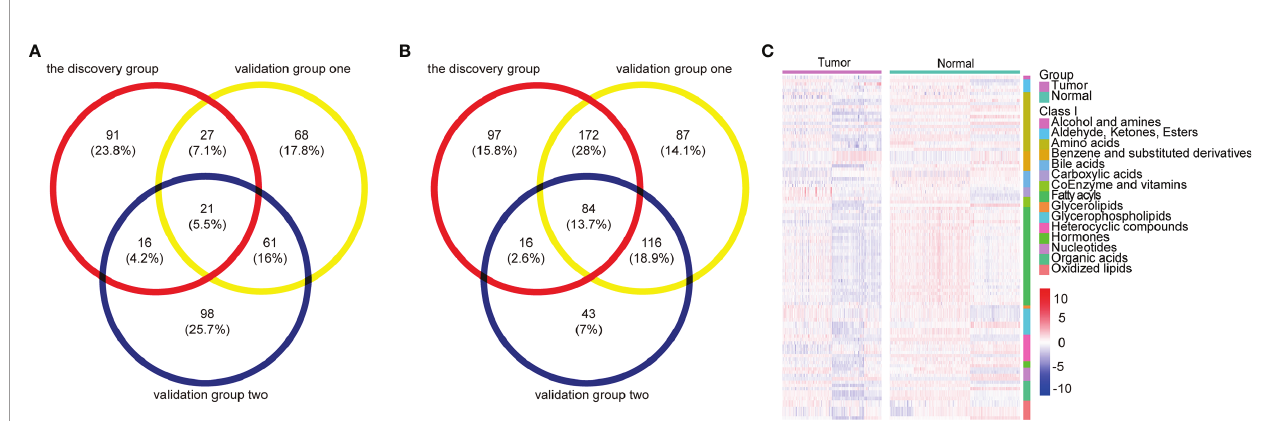
FIGURE 2 | Metabolomic pro fi les of patients with ESCC compared with controls. (A, B) Venn diagram of differential metabolites overlaps from the discovery and validation groups: 21 upregulated (A) and 84 downregulated (B) differential metabolites validated as reliable biomarker candidates with the same trend. (C) Heatmap summarizing differential metabolites in ESCC patients versus normal controls based on metabolite classes. Color bars at the right from top to down indicate samples from patients (purple) and controls (green), metabolites classes, and relative abundance of upregulated (red) and downregulated (blue) metabolites, respectively. Each column represents an individual subject, and each row a metabolite. See also Table S6